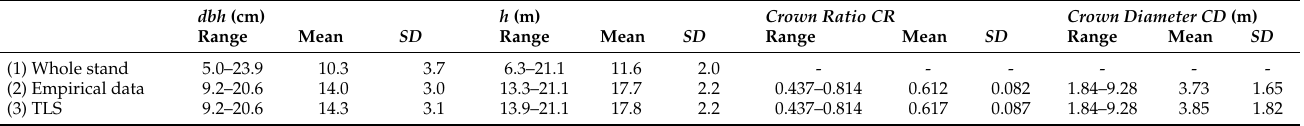
Table 1. Statistics (1) of the stand from where the sample trees were taken (estimates, obtained from an inventory with n = 6), (2) of the trees for which the horizontal branch biomass distribution was measured after felling ( n = 23) and (3) of the subset of 17 trees analyzed by terrestrial laser scanning (TLS) ( dbh stands for diameter at breast height, h for total tree height and SD for standard